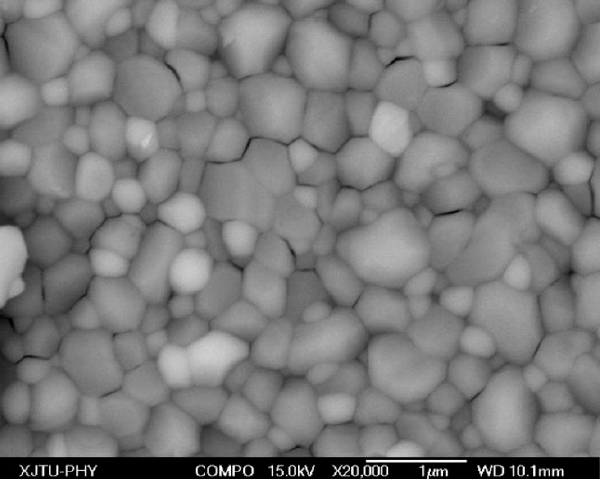
Figure 6. Backscattered electron image of the LaSZ sample after 90 h heat treatment at 1300 ◦ C.